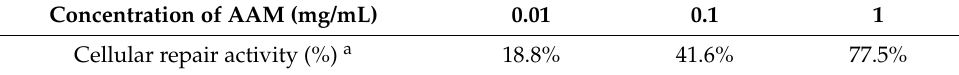
Table 3. Cellular repair activity of AAM in 3T3 cell line for 2 mM H 2 O 2 during 2.5 h by MTT assay. Concentration of AAM (mg/mL)